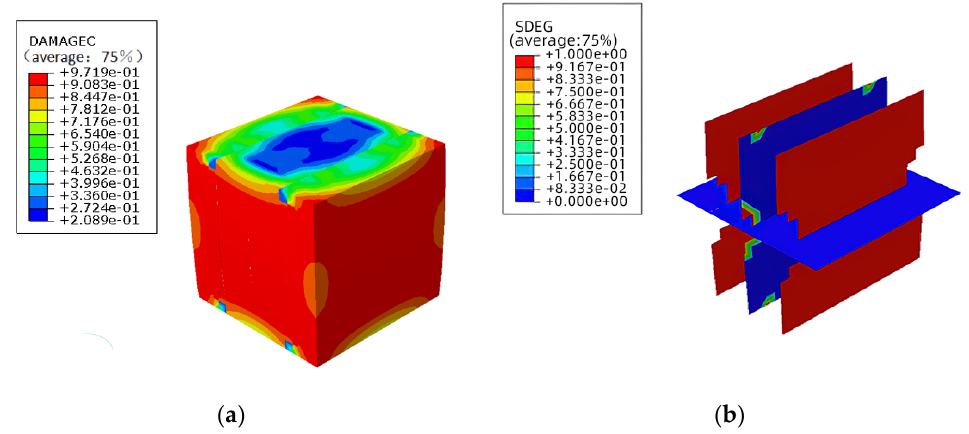
Figure 18. Damage cloud maps of specimen subjected to Y-axis loading compression. ( a ) Concrete compression damage ; ( b ) Adhesive unit damage .